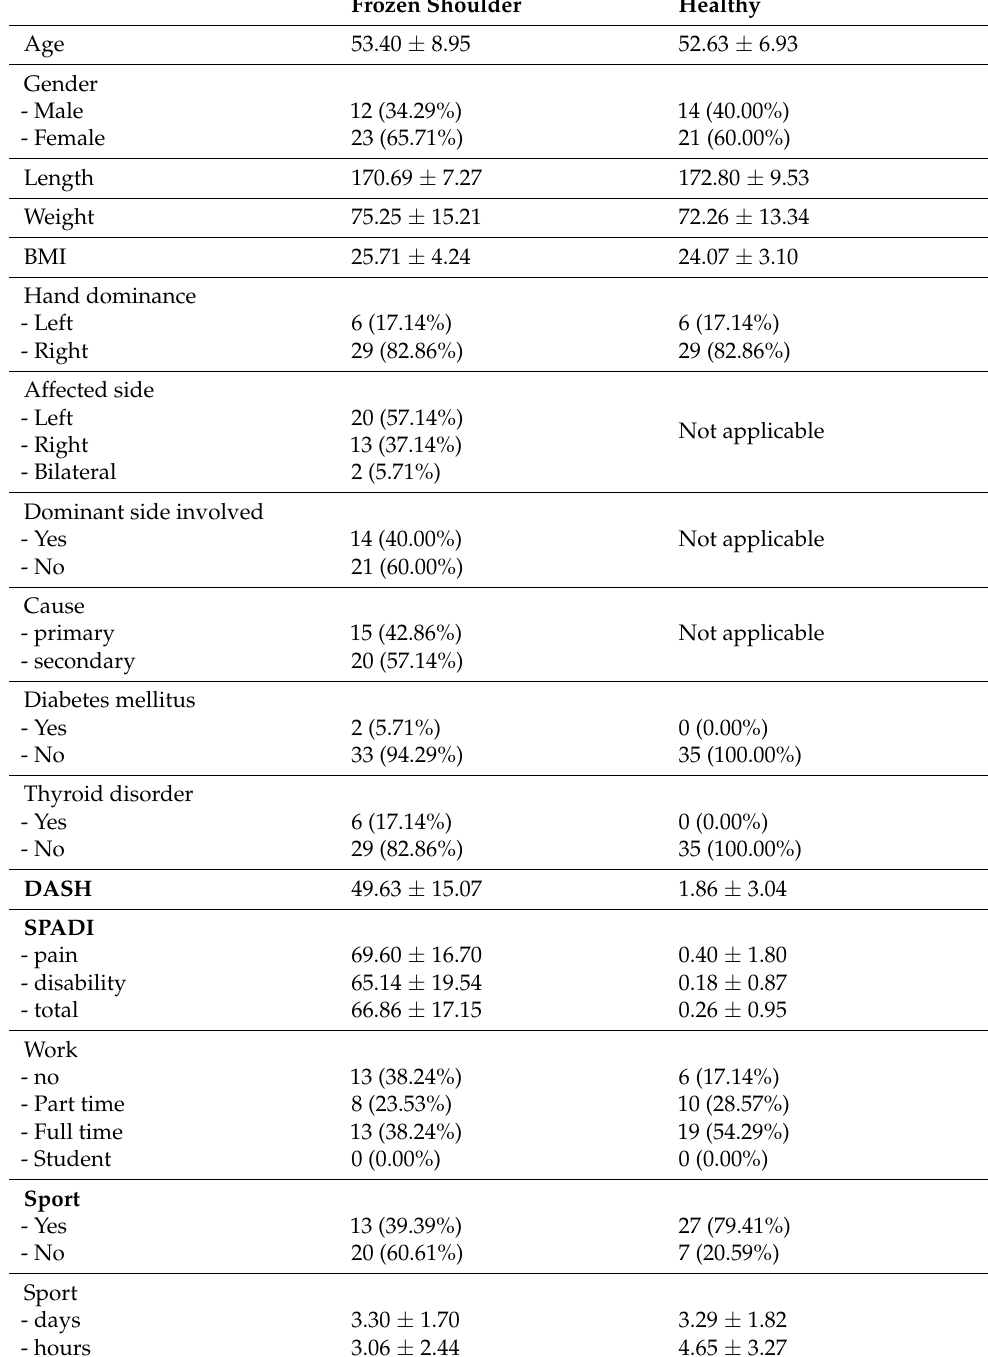
Table 2. Group characteristics of the included